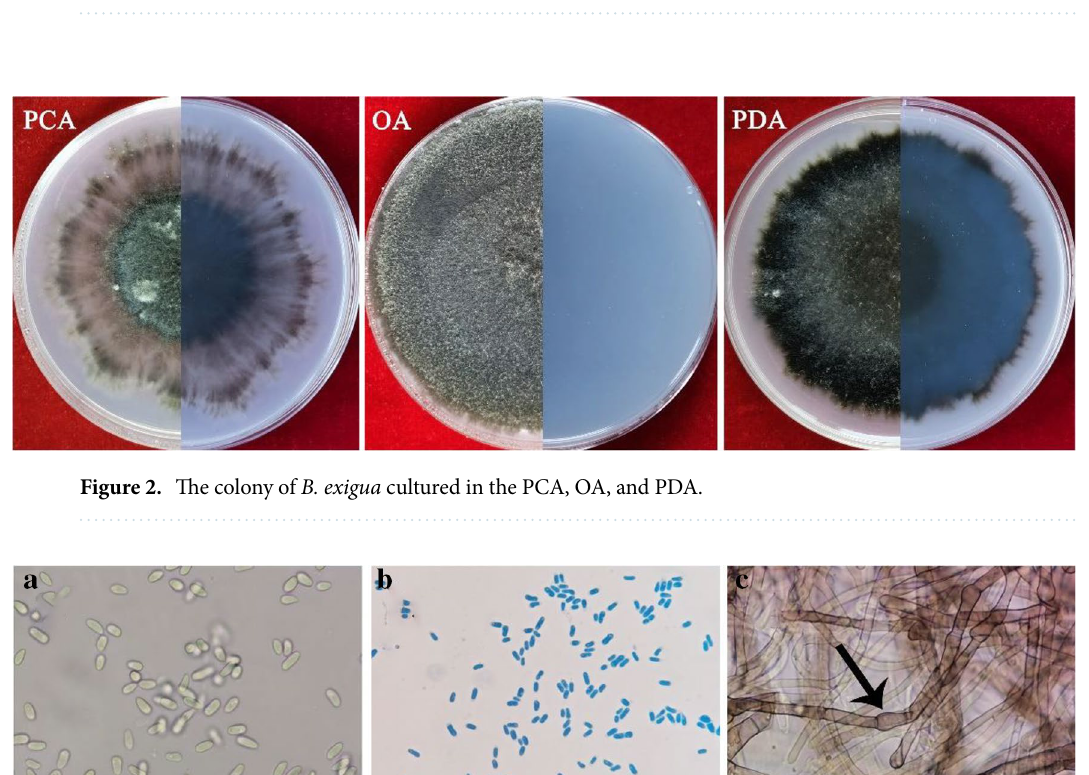
Table 1. The pathogens codes, isolation sources, and the ecotype codes of corresponding species of eight strains used in this study.